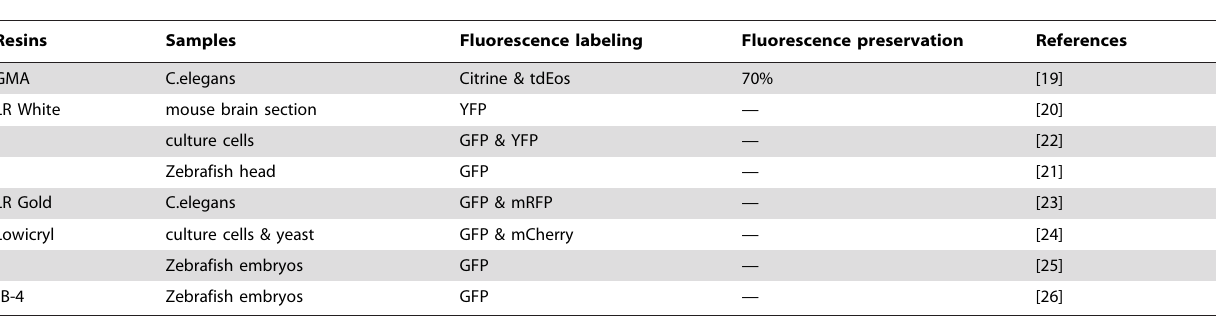
Table 1. Review on resins used for embedding samples expressing fluorescent protein.